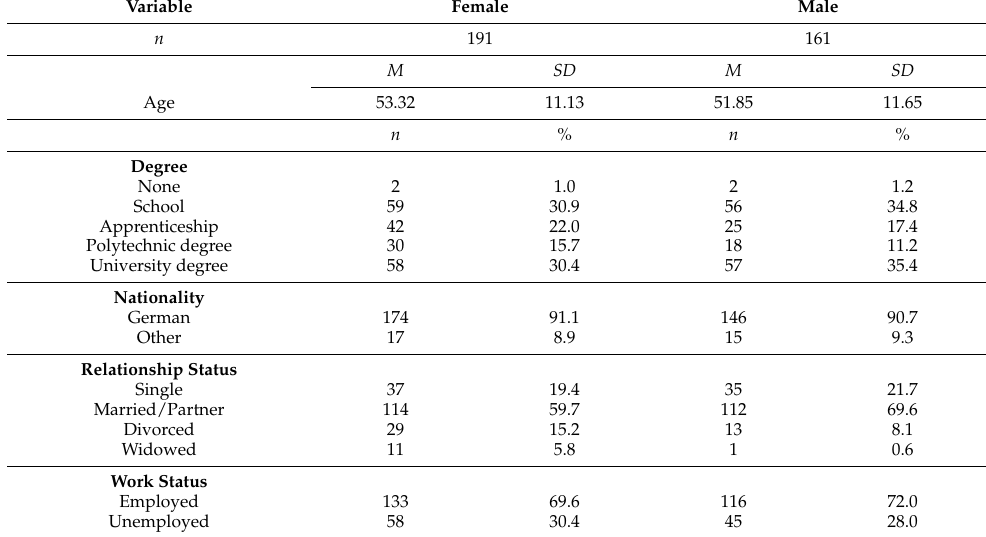
Table 1. Sociodemographic variables.